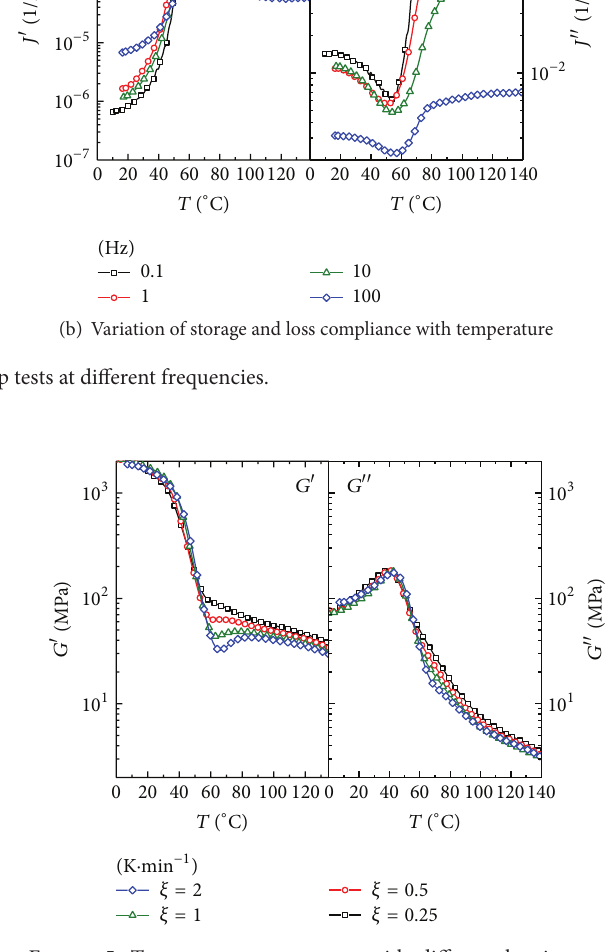
Figure 5: Temperature sweep tests with different heating rates: variation of storage and loss shear modulus with temperature.